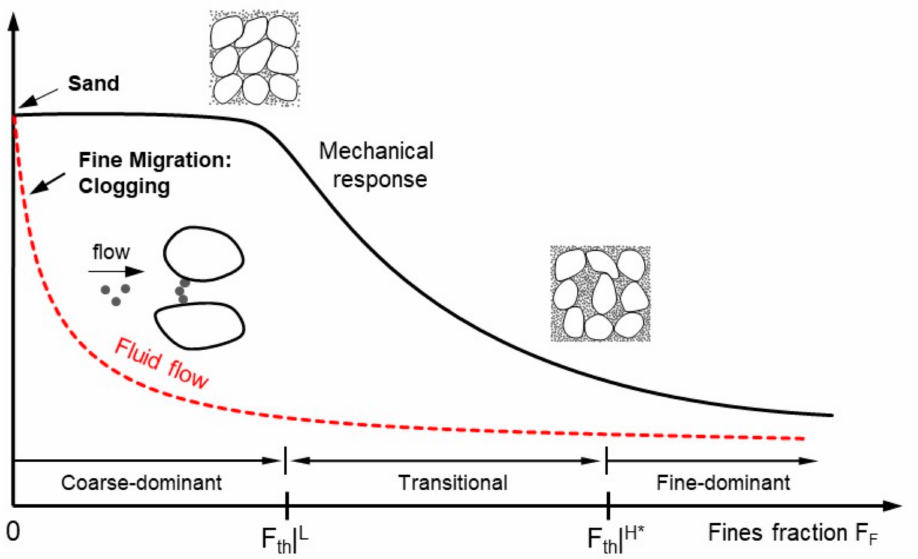
Figure 13. Conceptual drawing of changes in mechanical response and fluid flow in terms of low and data-adjusted high-threshold fines